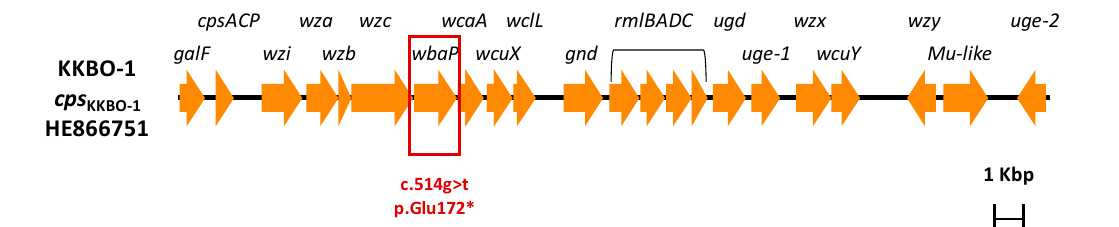
Figure 1. Genetic structure of the cps gene cluster of the KKBO-1 strain. The wbaP gene affected by the c.514g > t single nucleotide polymorphism leading to a premature termination (Glu172*) of the encoded glycosyltransferase is boxed. To confirm the role of the mutated wbaP in conferring resistance to the phage ϕ BO1E in BO-FR-1, a complementation experiment was performed using the pACYC-wbaP plas- mid containing a copy of the constitutive K. pneumoniae KKBO-1 wbaP gene together with its own putative promoter. The introduction of the wild-type wbaP gene in BO-FR-1 was able to restore both the mucoid phenotype of this strain and its susceptibility to ϕ BO1E infection (Figures 2 and S1).